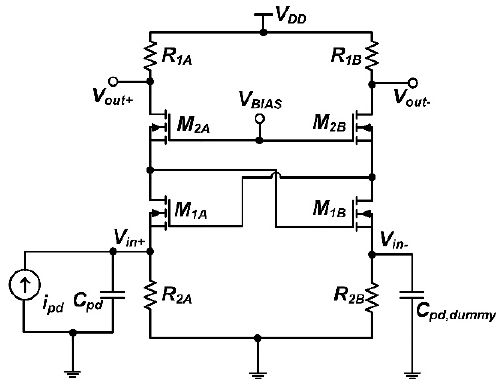
Figure 3. Cross-coupling differential TIA design with simple CG input design as in [15].